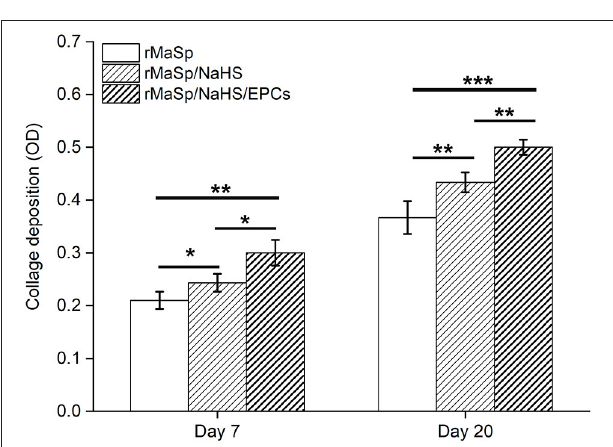
FIGURE 9 | Collagen deposition upon post wound detected on days 7 and 20. * p < 0.05, ** p < 0.01, *** p < 0.001 compared with the control group, n =